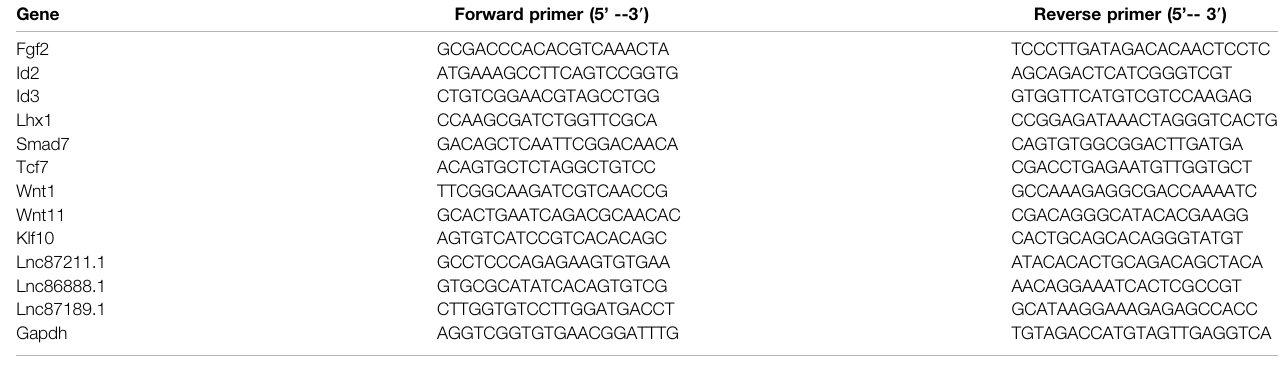
TABLE1 | RT-qPCR primers.